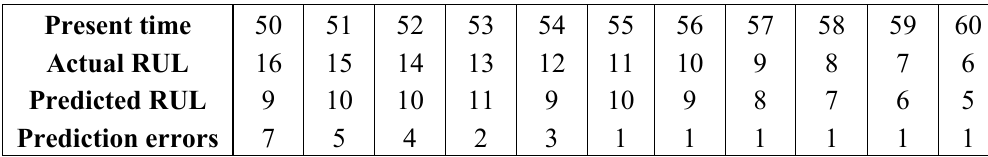
Table 1. Remaining useful life prediction